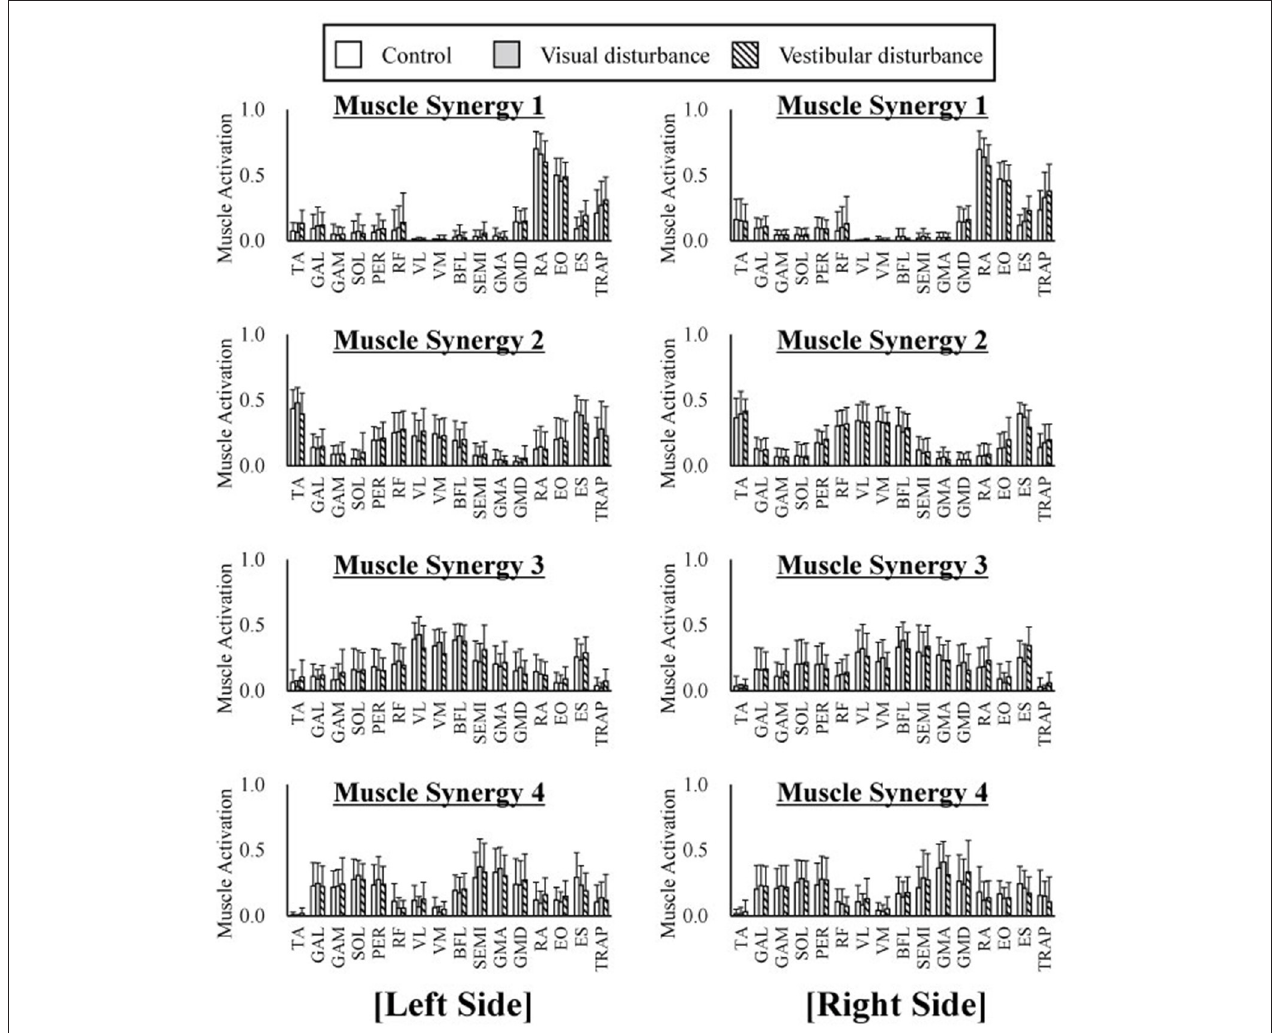
FIGURE 4 | The average and standard deviation of the spatial patterns of the muscle synergies under three different condition are displayed. Four graphs in the left of the figure represent the spatial patterns extracted from the left side of the subjects whereas the right of the figure indicate the spatial patterns extracted from the right side. This graph is based on 120 samples in total. Each spatial pattern has specific contribution to the sit-to-stand motion. The muscle synergy 1 activates RA and EO to flex upper body. The muscle synergy 2 activates TA, VL, VM, and VM to rise hip from a chair and move forward. The muscle synergy 3 activates VL, VM, and ES to extend whole body. At last the muscle synergy 4 activates GAL, GAM, SOL, GMA, and GMD to stabilize posture. It has been shown that spatial patterns are similar regard less of different sensory